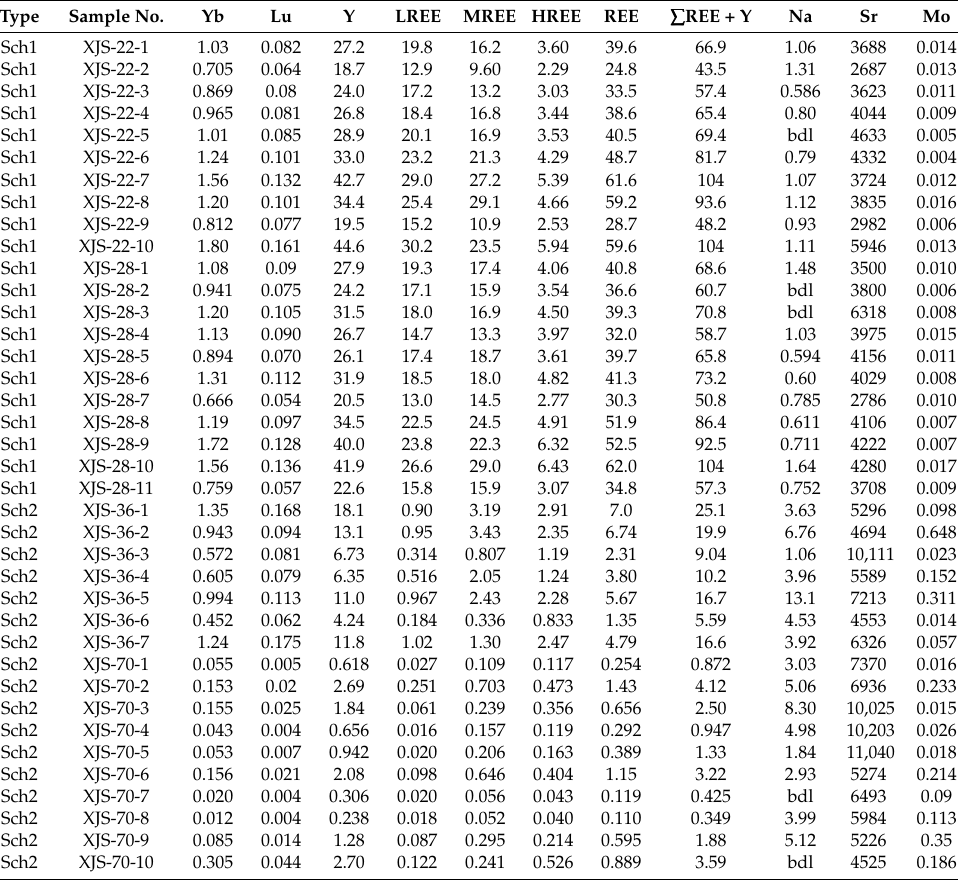
Table 2. REE and trace element compositions (ppm) of scheelite from the Longshan Sb-Au deposit, South